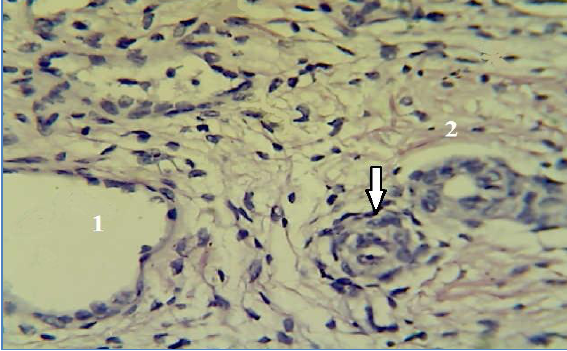
Figure, 3: The medulla of the ovary in goat of group (A) showing tubules of rete ovarii (arrow), large blood vessel (1), smooth muscle fiber. (PAS stain